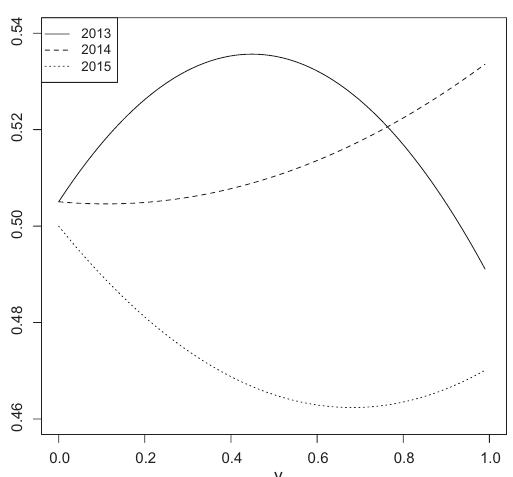
Figure 8. ^ P ð U > u 0 j V > v Þ according equation (2), v 2 ½ 0 ; 1 (cid:3) ; years: 2013, 2014 and 2015, with u 0 given by Table 5.